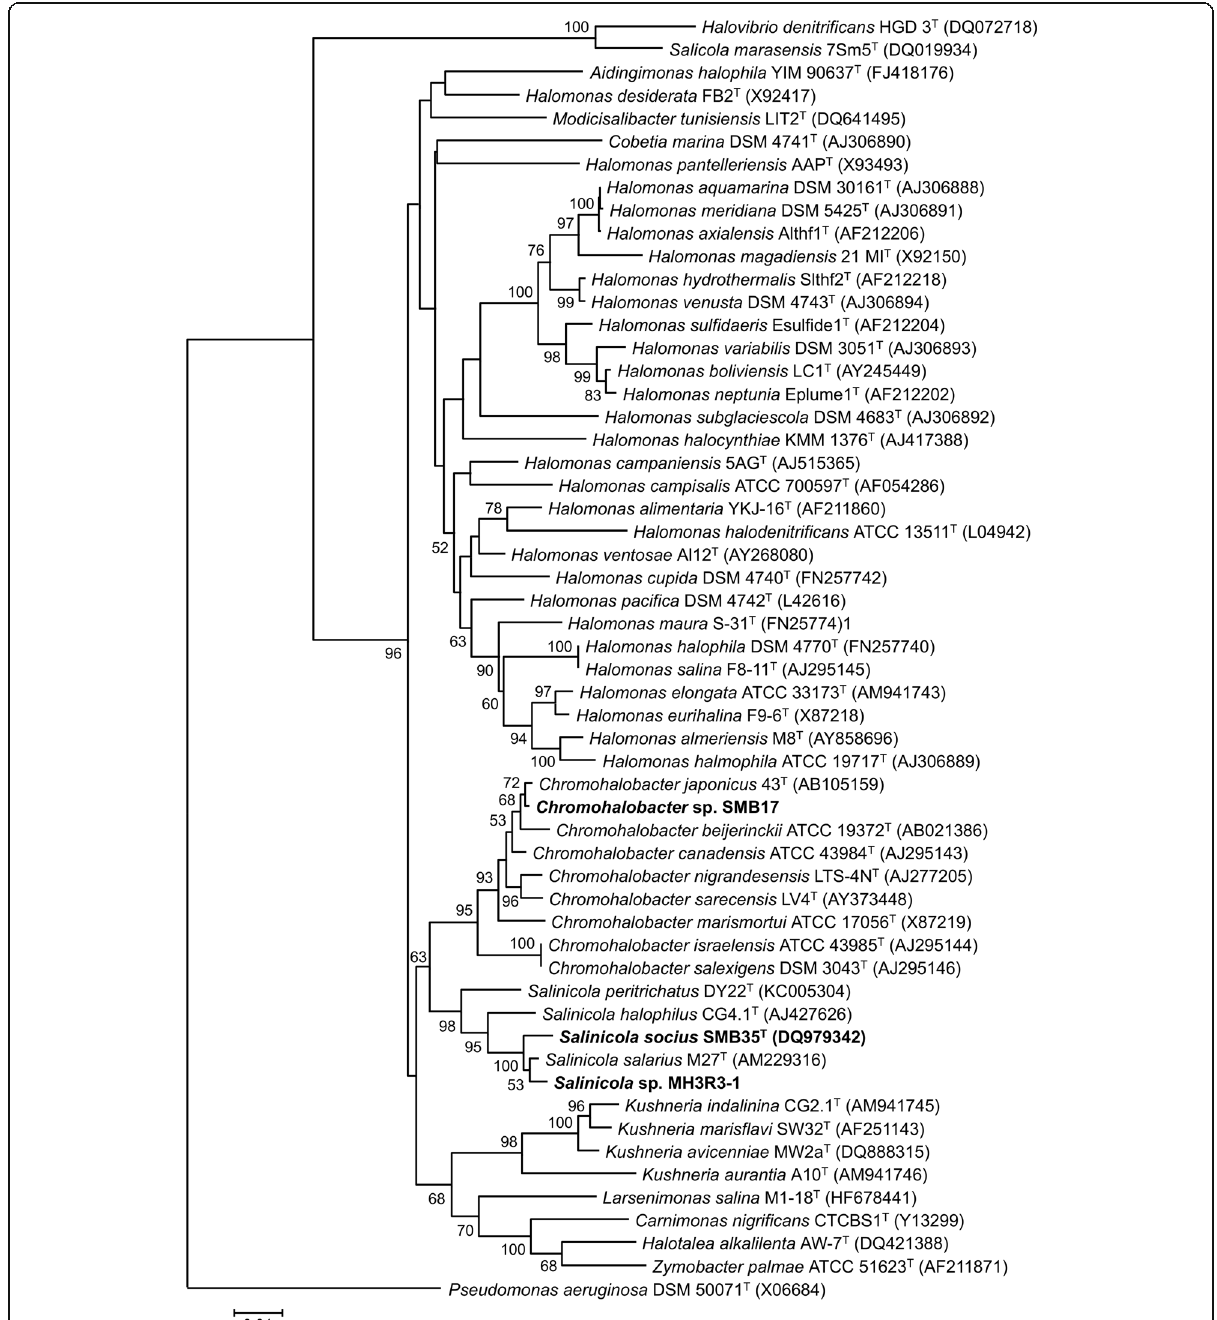
Fig. 2 Neighbor-joining phylogeny inferred from data for 16S rRNA sequences of S. socius SMB35 T , Salinicola sp. MH3R3 – 1, Chromohalobacter sp. SMB17 and other species of the Halomonadaceae family. The optimal tree with the sum of branch length = 0.95863591 is shown. The percentage of replicate trees in which the associated taxa clustered together in the bootstrap test (1000 replicates) are shown next to the branches. The tree is drawn to scale, with branch lengths in the same units as those of the evolutionary distances used to infer the phylogenetic tree. The evolutionary distances were computed using the Kimura 2-parameter method [39] and are in the units of the number of base substitutions per site. The analysis involved 56 nucleotide sequences. All positions containing gaps and missing data were eliminated. There were a total of 1241 positions in the final dataset. Evolutionary analyses were conducted in MEGA7